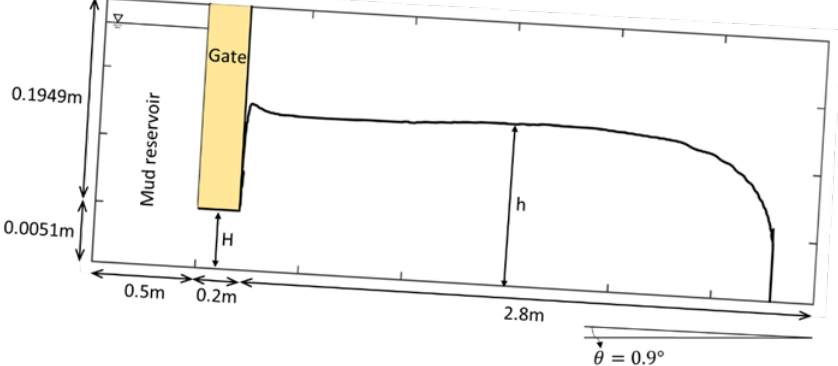
Figure 3. Numerical setup of Bingham flow on an inclined plane based on the experiment of Liu [12].